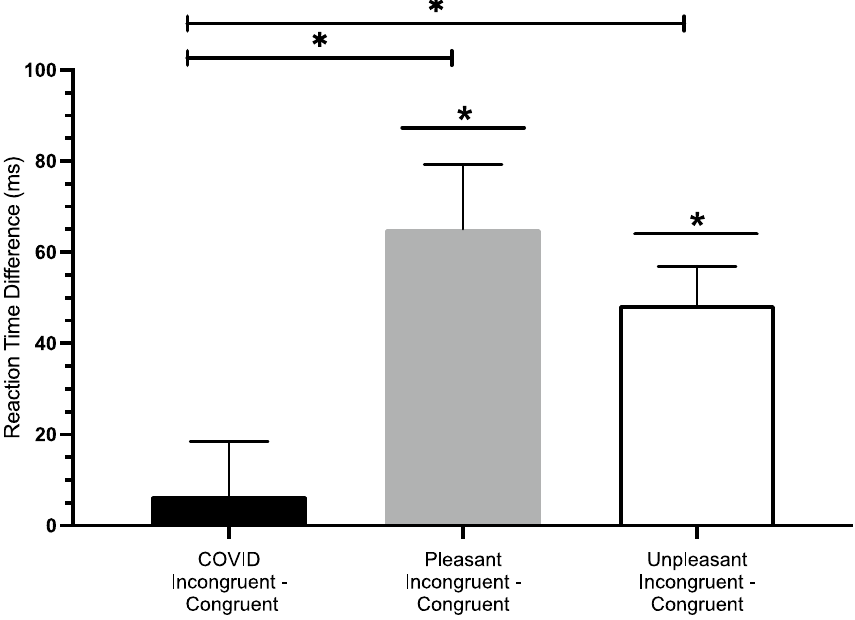
Figure 4. Difference scores, generated by subtracting congruent from incongruent reaction times, are plotted for each of the COVID-19 (black), pleasant (grey), and unpleasant (white) word categories. Pleasant (grey) and unpleasant (white) word category bias scores are also significantly different from zero indicating affective